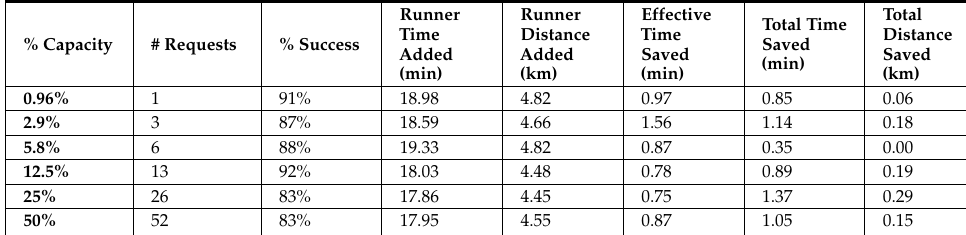
Table 7. Results from Harlem feasibility study.